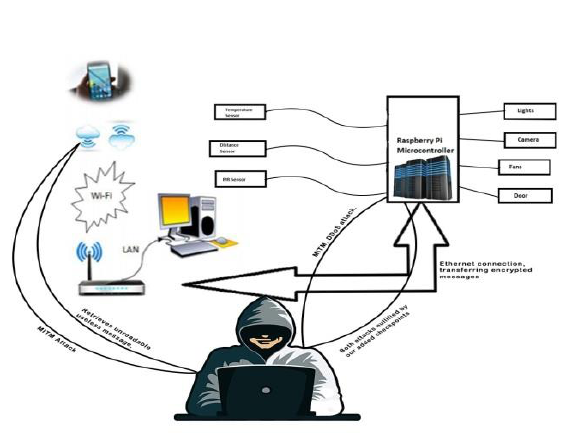
Fig.2. Architecture diagram of the proposed system In some applications only simple